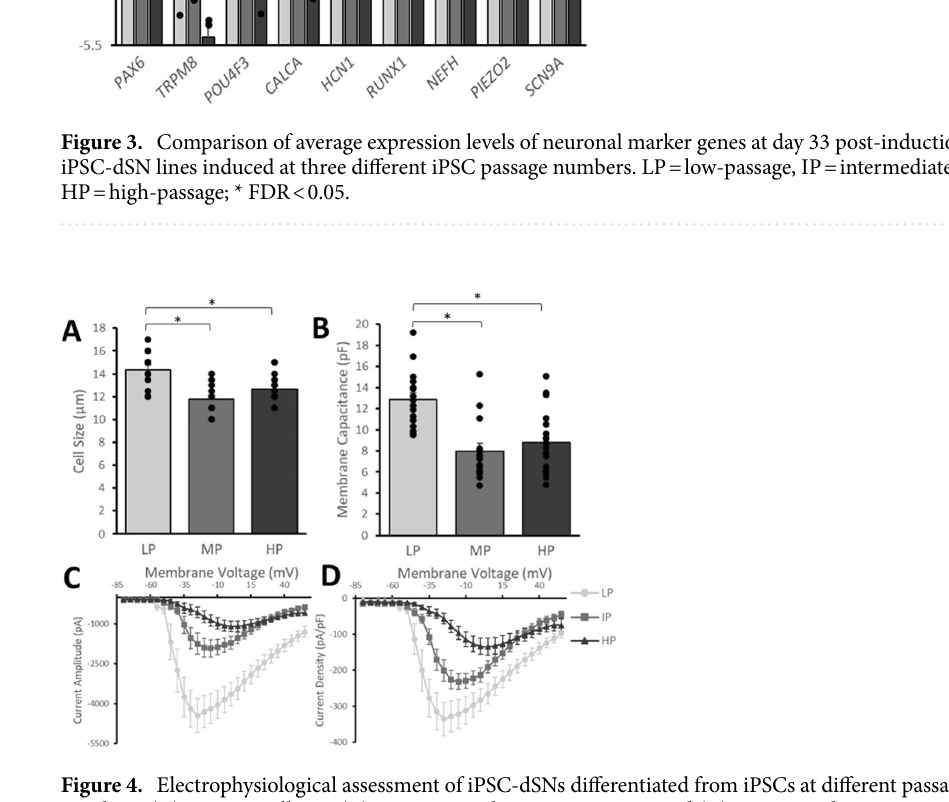
Figure 4. Electrophysiological assessment of iPSC-dSNs differentiated from iPSCs at different passage numbers. ( A ) Average cell size, ( B ) average membrane capacitance, and ( C ) average sodium current amplitude and ( D ) density from whole-cell patch-clamp recordings. Experiments were performed using 16, 14, and 18 iPSC-dSNs of low-, intermediate-, and high-passage, respectively. LP = low-passage, IP = intermediate-passage, HP = high-passage; * p -value <